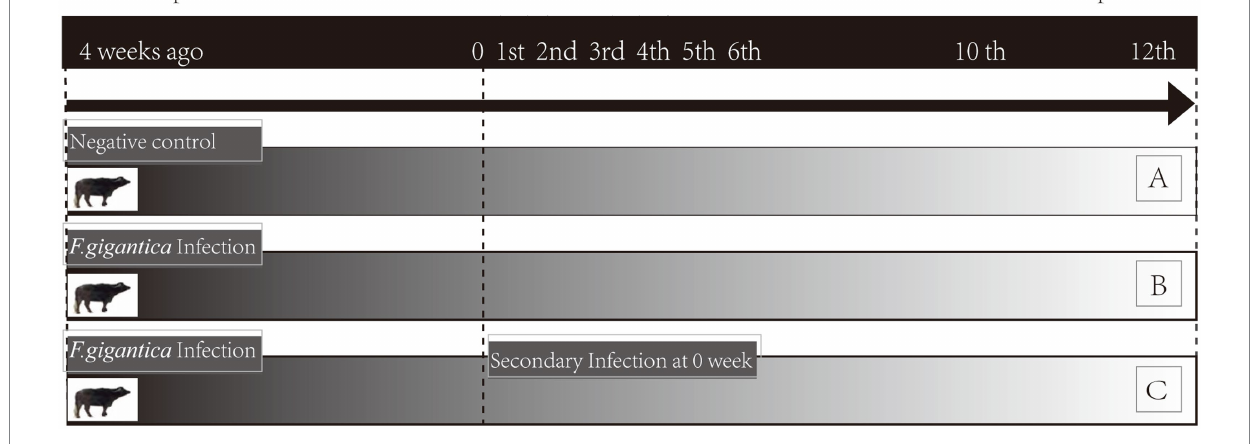
FIGURE 1 Experimental design. Noninfected buffaloes as negative control (group A); primary infected buffaloes (group B) received a single infection dose; secondary infected buffaloes (group C) received a primary infection and subsequent secondary infection at 4 wpi. Whole blood of groups A, B, and C were collected simultaneously pre-infection (week 0) and post-infection (weeks 1–6, 10, and